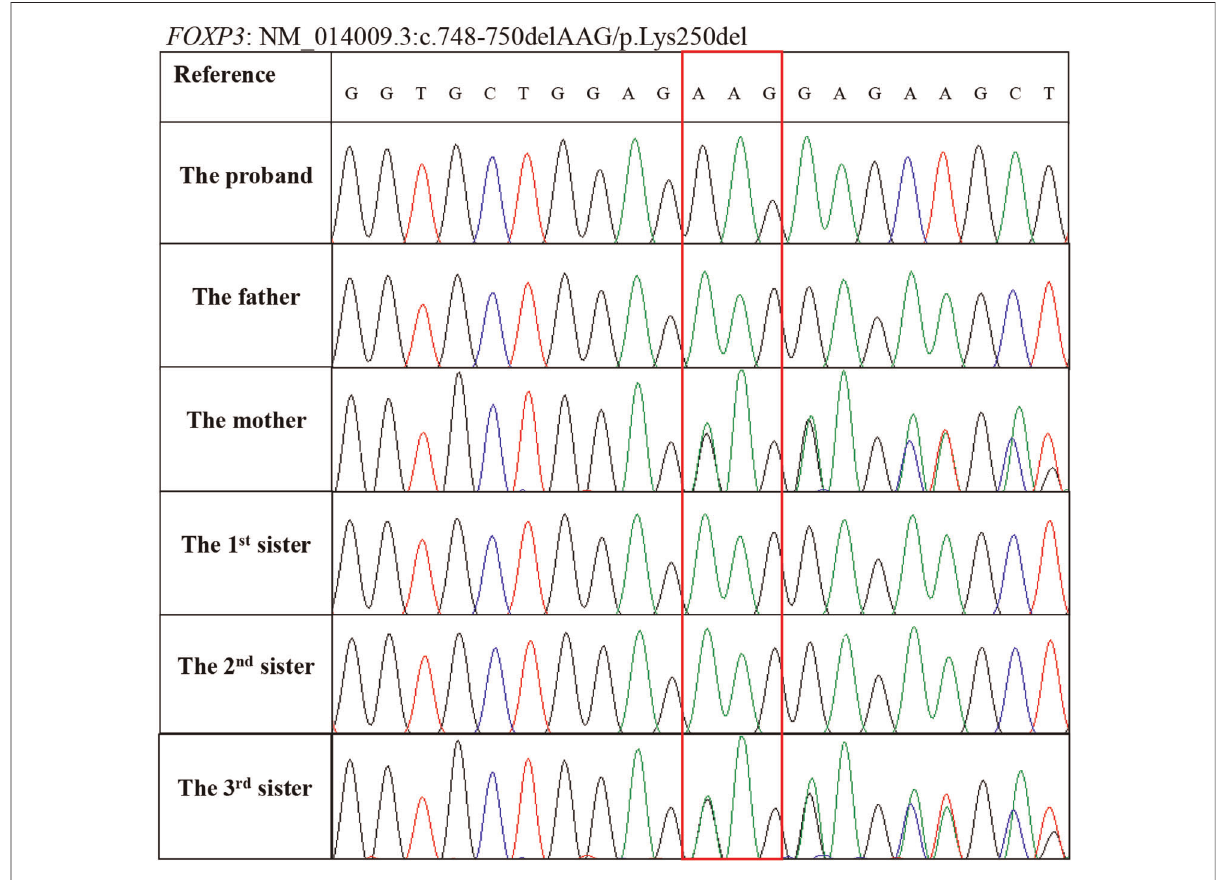
FIGURE 4 Genotyping of the FOXP3 gene mutation c.748 – 750delAAG (p.Lys250del) in the family members using Sanger